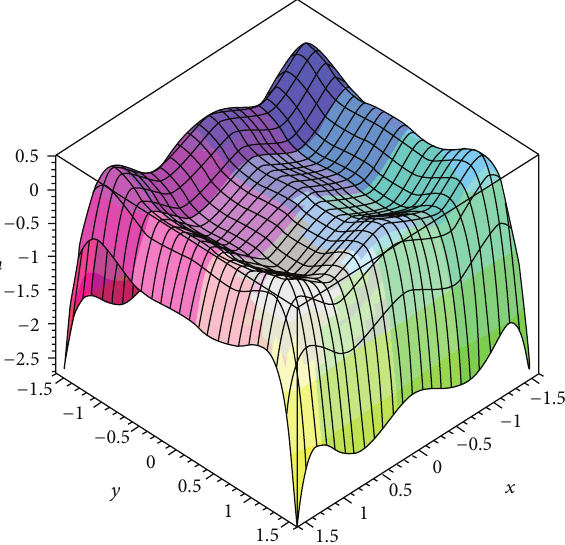
Figure 1: The diagram of the Hamiltonian function (15) is